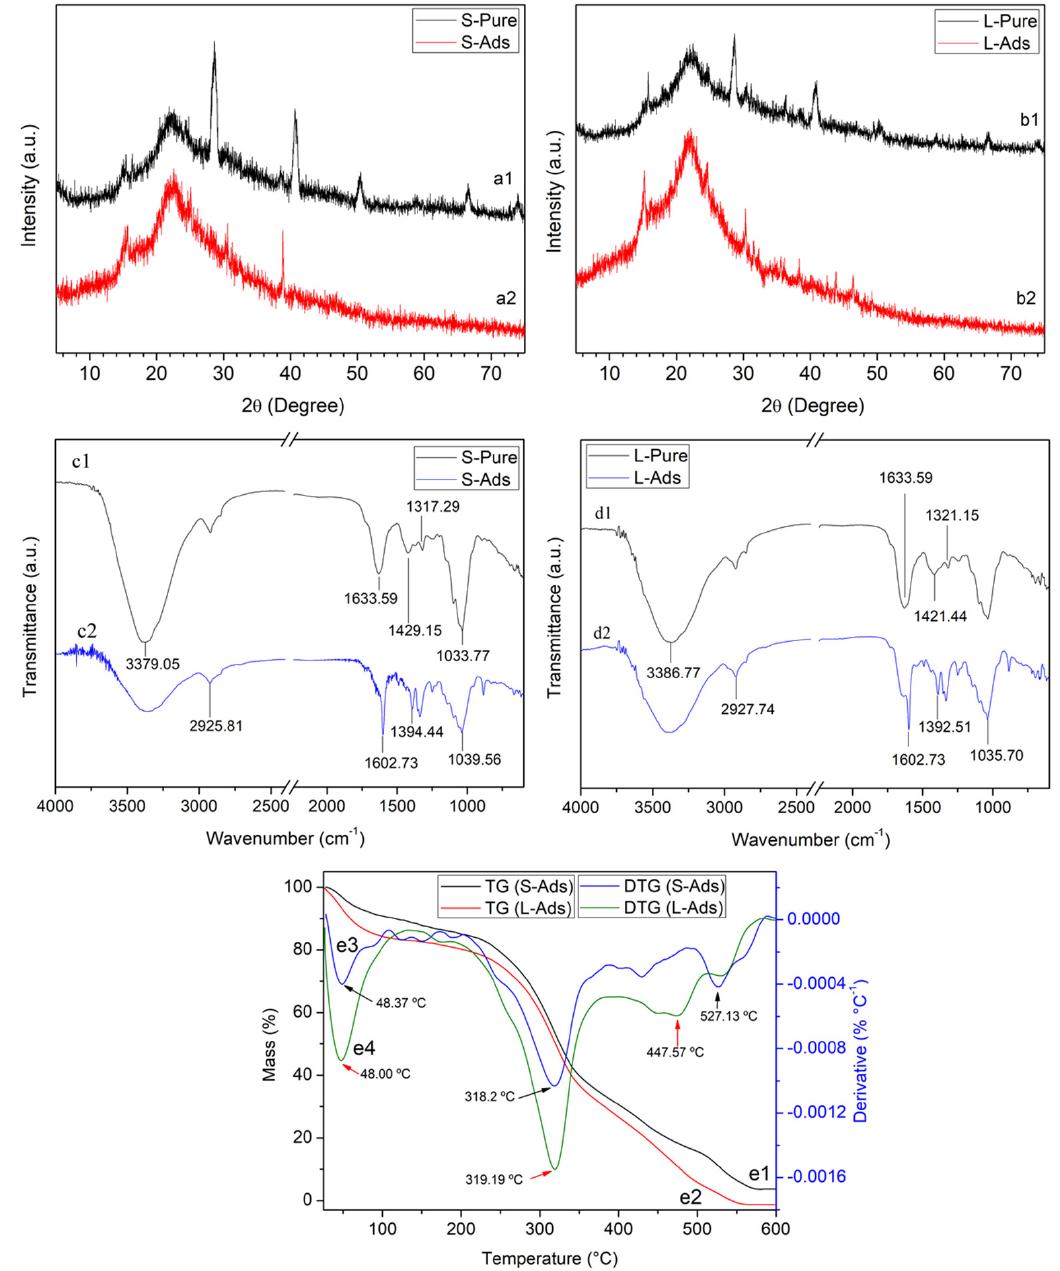
Figure 8. X-ray diffractograms of water hyacinth stem: (a1) before adsorption, (a2) after adsorption; and leaf:(b1) before adsorption, (b2) after adsorption; FTIR of water hyacinth: stem: (c1) before adsorption, (c2) after adsorption; and leaf: (d1) before adsorption, (d2) after adsorption; TG of water hyacinth: (e1) stem and (e2) leaf after adsorption. DTG of water hyacinth: (e3) stem and (e4) leaf after adsorption.